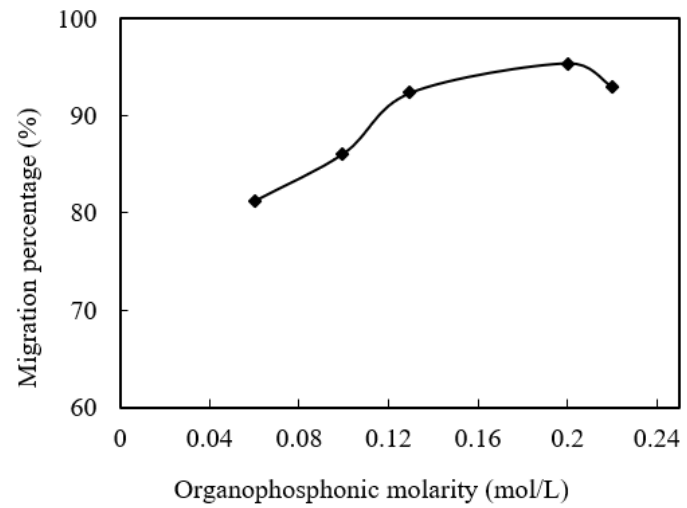
Figure 11. Effect of organophosphonic liquid on molarity.